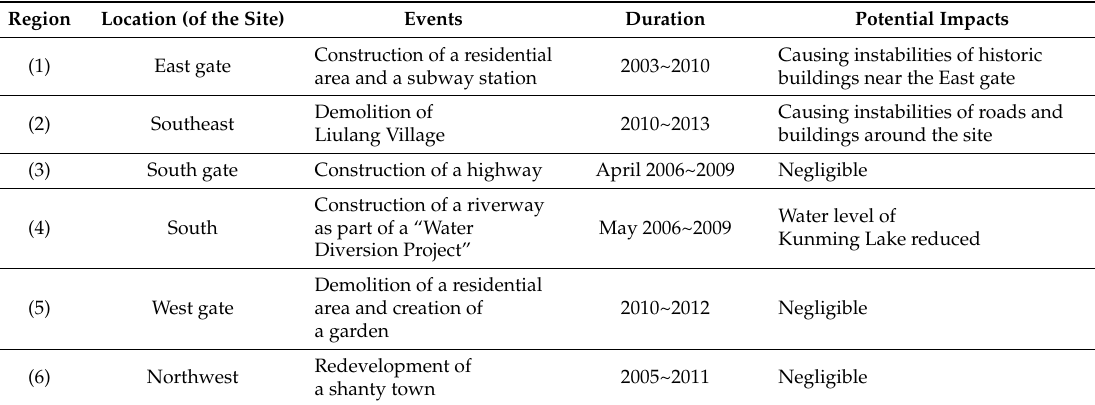
Table 1. Descriptions of construction and demolition activities in the vicinity of the heritage